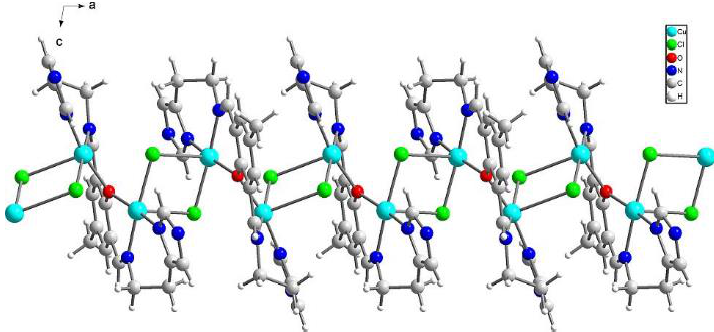
Figure 2. Perspective view of 1 along the crystallographic b axis.